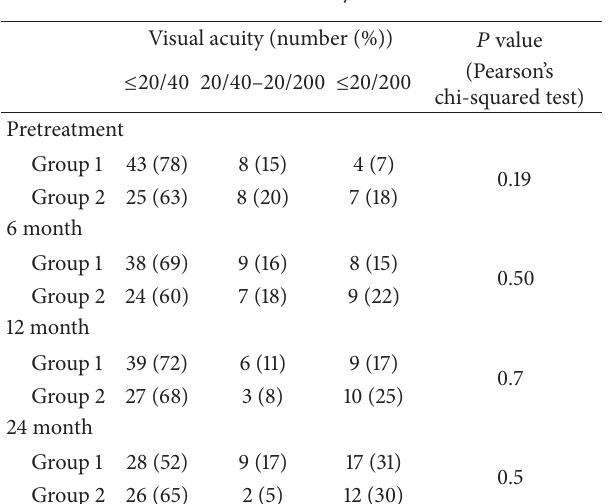
Table 3: Visual acuity